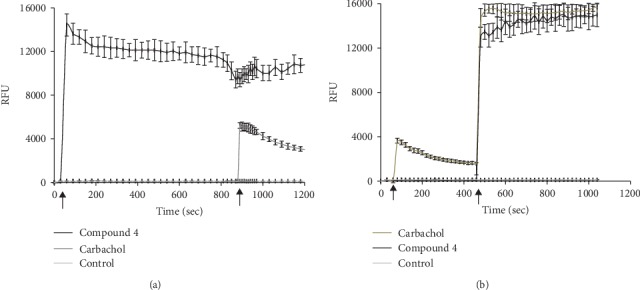
Carbachol effect on agonist activity of compound 4. (a) The carbachol-induced [Ca2+]i increase after stimulation of cells with compound 4. The cells were stimulated with compound 4 (first arrow) and after 880 s were stimulated with 100 nM carbachol (second arrow). (b) The compound 4 induced [Ca2+]i increase after stimulation of cells with carbachol. The cells were stimulated with 100 nM carbachol (first arrow) and after 460 s were stimulated with 100 μM compound 4 (second arrow). Control is Fura-4 NW loaded cells without stimulator. Values were presented in RFU (relative fluorescence units) ± SD.